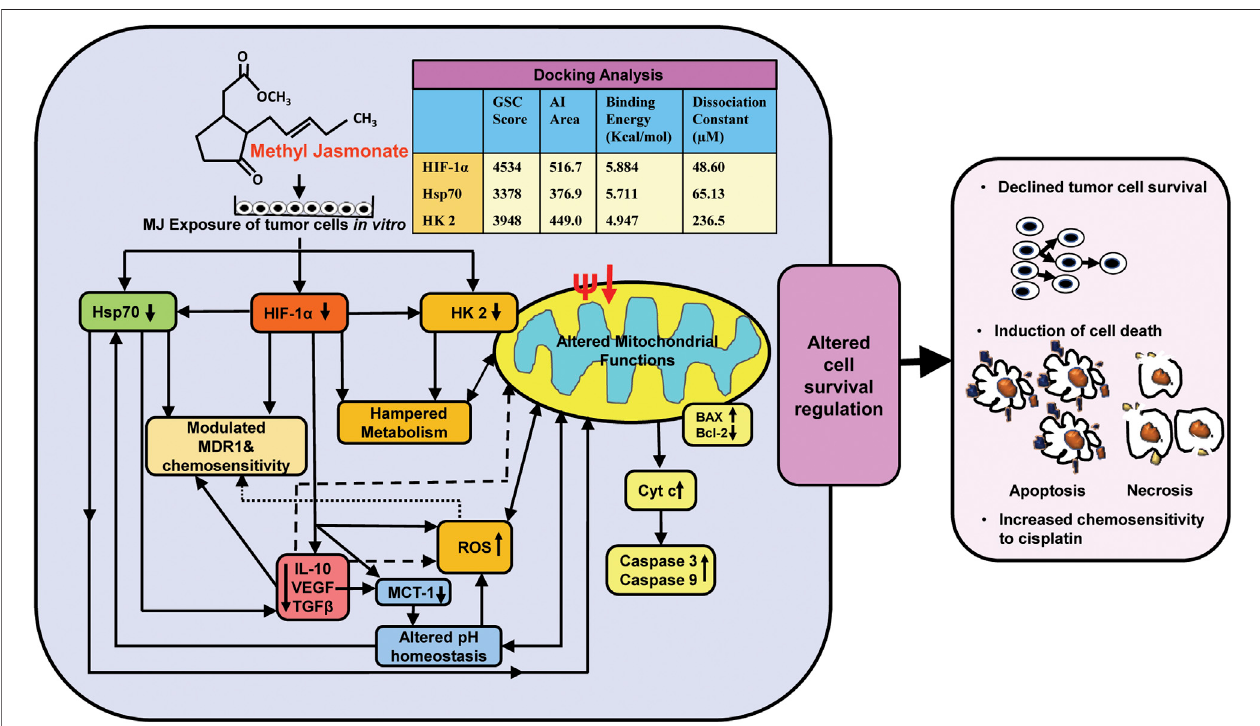
FIGURE 6 | Summary of the molecular mechanisms underlying cytotoxic, antimetabolic, and chemosensitizing action of MJ against T cell lymphoma. The fi gure presentsasummaryofthemoleculareventsimplicatedinthecytotoxic,antimetabolic,andchemosensitizingactionofMJagainstDLcells invitro anddockinganalysisof MJ with indicated metabolic and cell survival regulatory